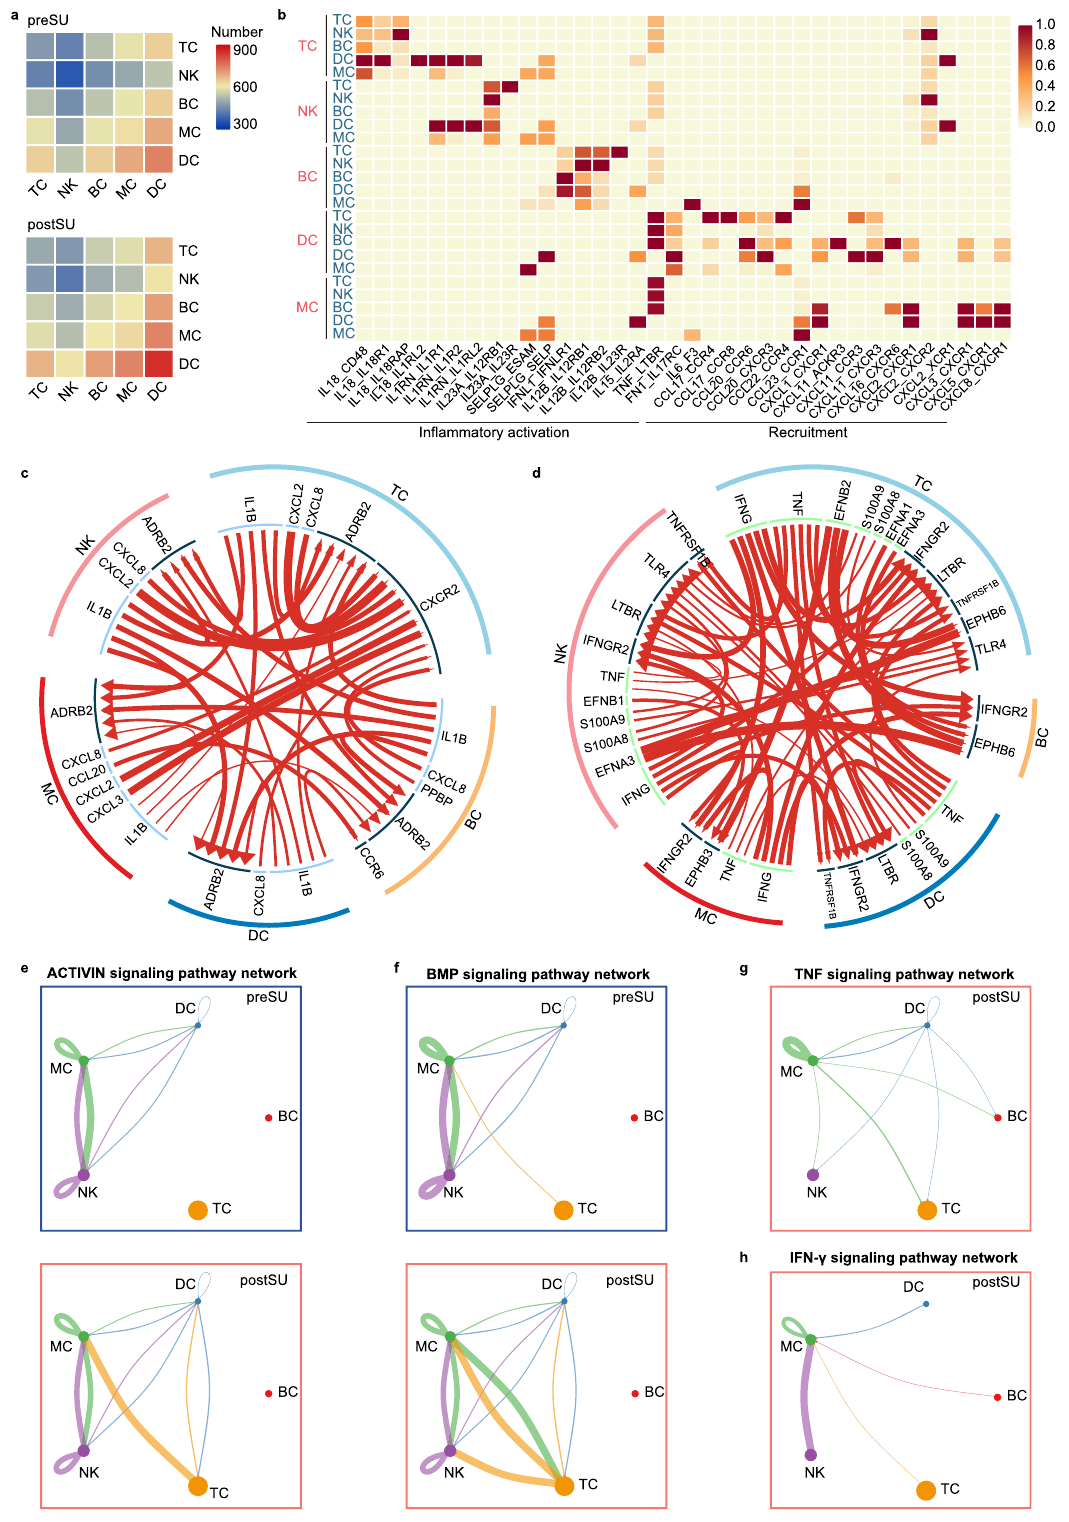
Fig. 6 Enhanced cell chemotaxis and in fl ammatory activation in cell-cell communication in SU blood. a Heatmap depicting the number of possible interactions between the clusters analyzed in preSU and postSU groups. b Heatmap depicting selected cell-cell interactions enriched in postSU group but absent in preSU group. c Circle plot showing upregulation in cellular interaction of cytokine type predicted in iTALK package. d Circle plot showing upregulation in cellular interaction of other type predicted in iTALK package. e Circle plot showing the inferred ACTIVIN signaling networks. f Circle plot showing the inferred BMP signaling networks. g Circle plot showing the inferred TNF signaling networks in postSU group. h Circle plot showing the inferred IFN- γ signaling networks in postSU